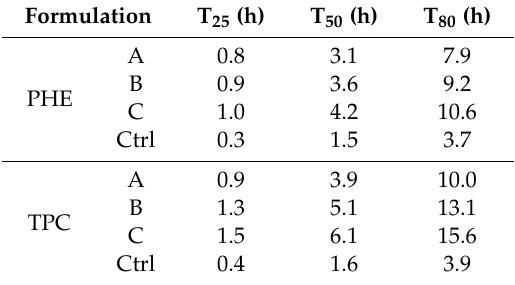
Table 7. Drug release kinetic parameters of formulations A, B, and C in a semi-solid adapter.